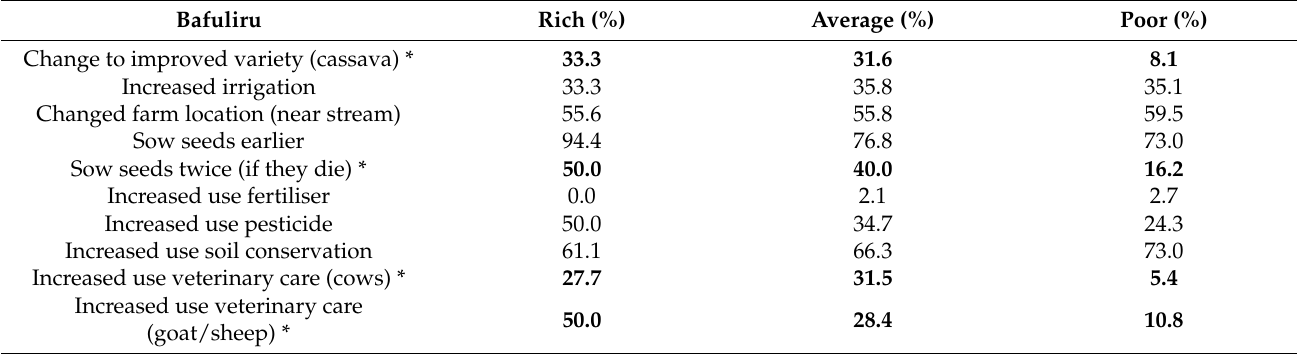
Table 2. Differential adaptation responses by wealth groups among the Bafuliru ( n = 150) and the Lega ( n = 150). ‘ % ’ refers to the percentage of respondents within a wealth group. Bold values and * indicates significant differences across the wealth groups at p < 0.05, using cross-tabulation tables and chi-square tests.